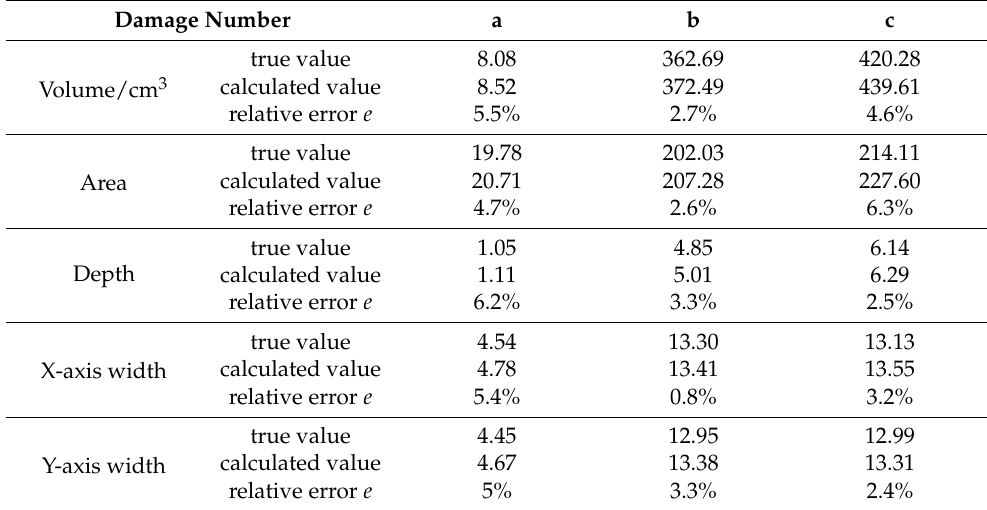
Table 3. Calculation and Error of Damage Geometry